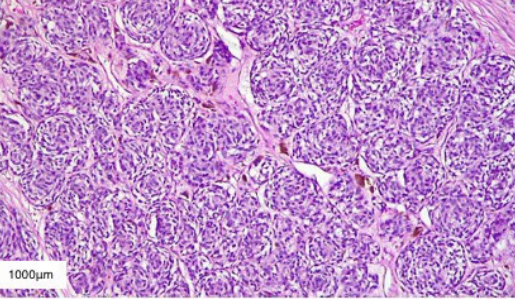
Figure 9. HE-stained (10×) histopathological section of glioblastoma multiforme. Scale bar: 1000 μm. Immunohistochemical staining was positive for Vimentin, S100 protein, but negative for Melan-A, which excluded a melanocytic origin. In addition, glial fibrillary acidic protein (GFAP) and isocitrate dehydrogenase-1 (IDH1 ) were diffusely positive, while Ki-67 was positive in approximately 40% of the tumor cells. Immunohistochemistry confirmed the diagnosis of high-grade glioblastoma, but its primary or secondary nature was